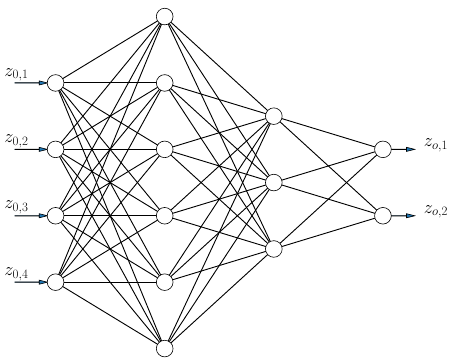
Figure 1. Structure of an Artificial Neural Network (ANN), which consists of multiple nonlinear transformations σ ( W i z i − 1 ) of the inputs z 0